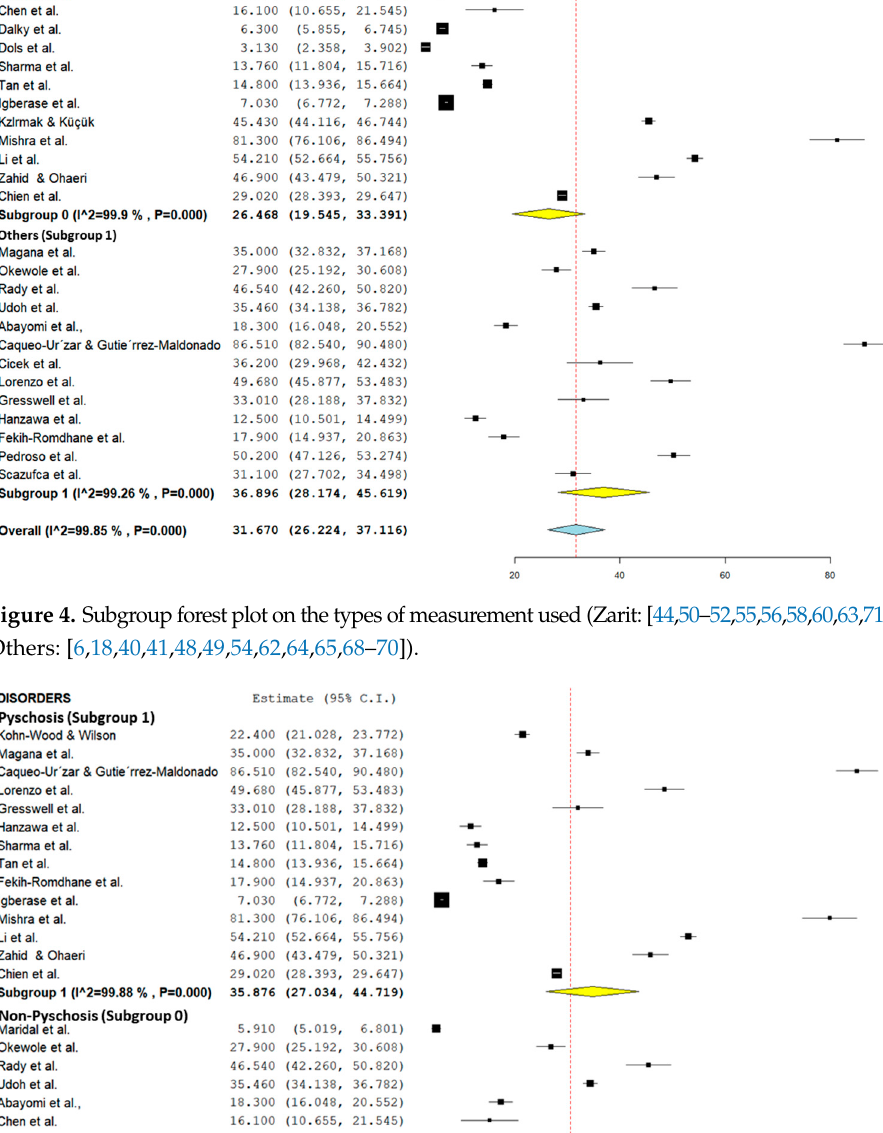
Figure 3. Subgroup forest plot on the study setting (Community: [50,58,64,68–70,75,77]; Clinic: